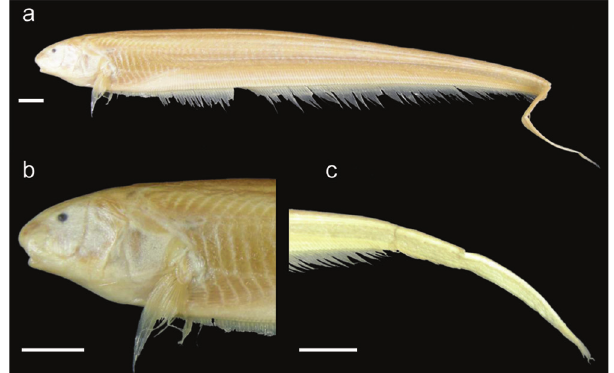
Fig. 18. Sternarchella orinoco (USNM 228727). a. Lateral view of the body, b. Lateral view of the head, c. Lateral view of the caudal region showing a single row of intermuscular bones in the caudal peduncle and the discontinuous caudal peduncle membrane. Scale bars = 1 cm. Tab. 6. Morphometrics and meristic measurements for Sternarchella